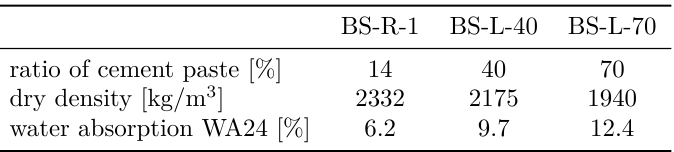
Table 2. Properties of the crushed sands.